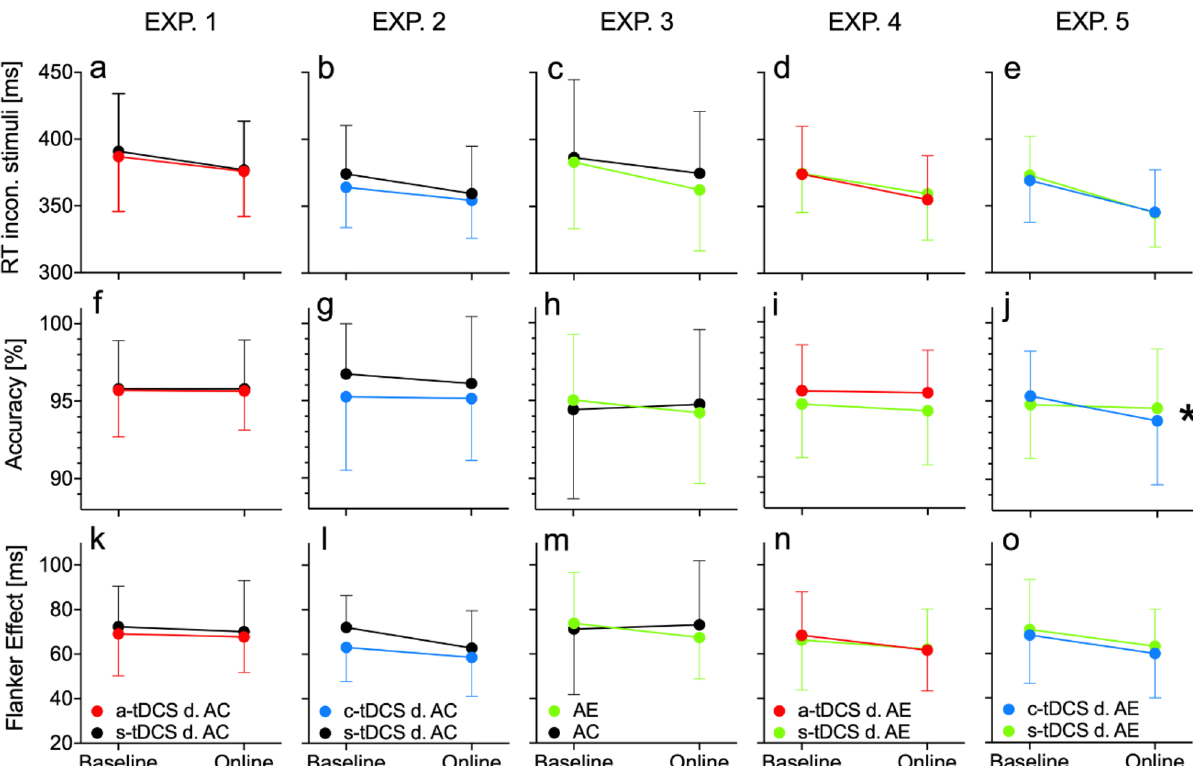
Figure 1. Results for the flanker task across experiments. Time × Condition interaction plots are displayed for the three variables reflecting Flanker test performance. The mean baseline and online values are plotted as the arithmetic mean and standard deviations. Statistical data are reported in the Result section. *asterisk displays a sig. ( p < 0.05) interaction effect. AE = active control, AE = aerobic exercise. Figure drawn with GraphPad Prism version